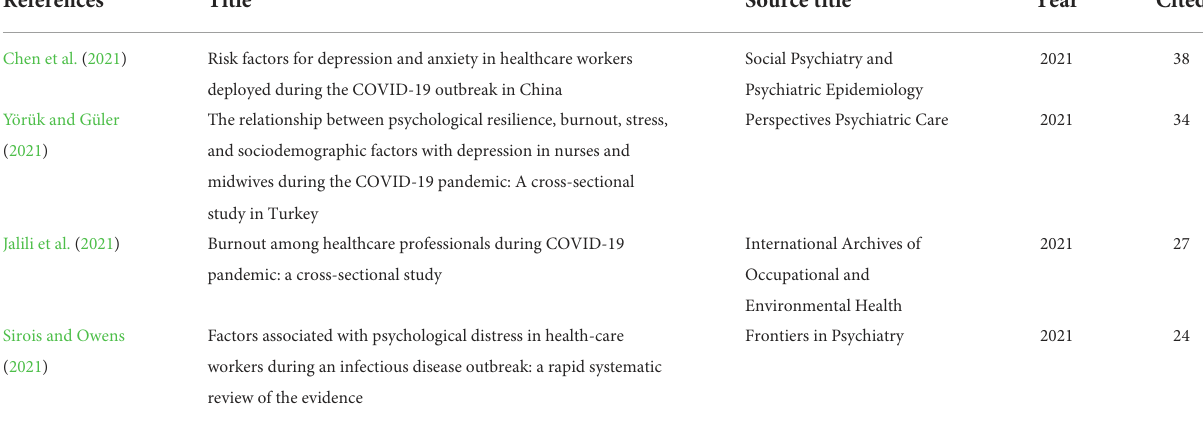
TABLE 2 Top 4 most global and local cited publications (2021).